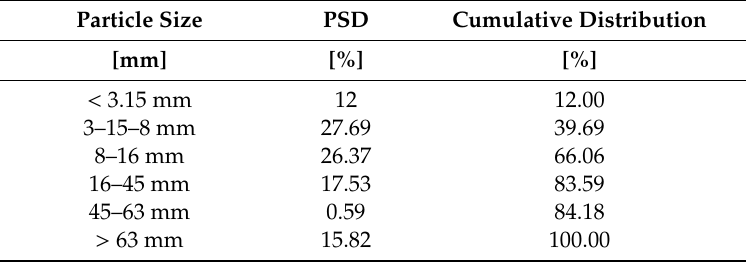
Table 4. Particle size distribution (PSD) of the Facma Comby TR200 hog